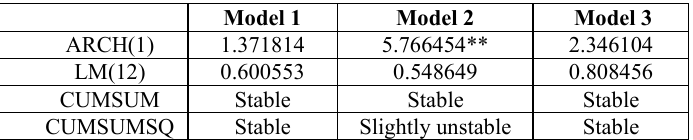
Table 3. Diagnostic